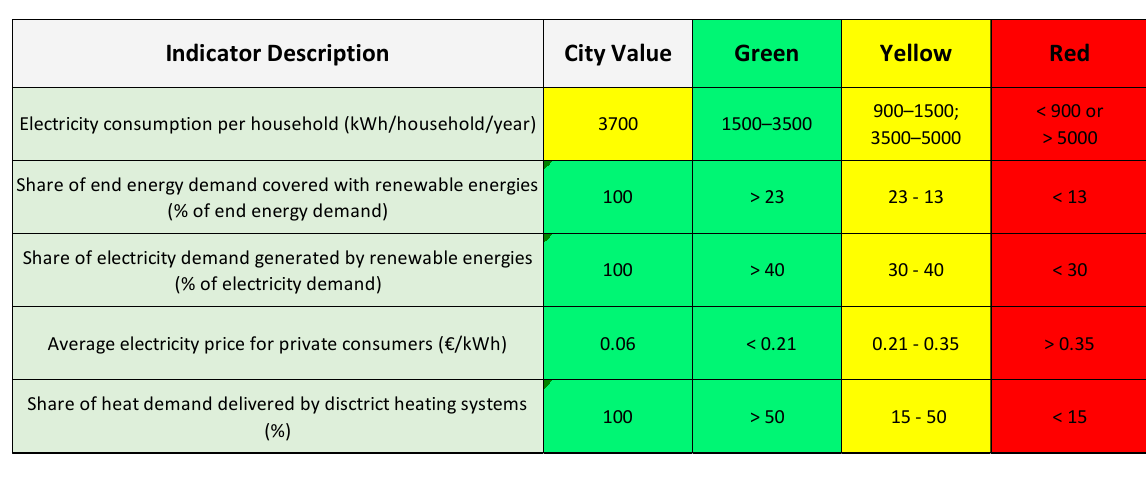
Figure A2. Sample of assessed energy indicators adapted for the project from Morgenstadt.